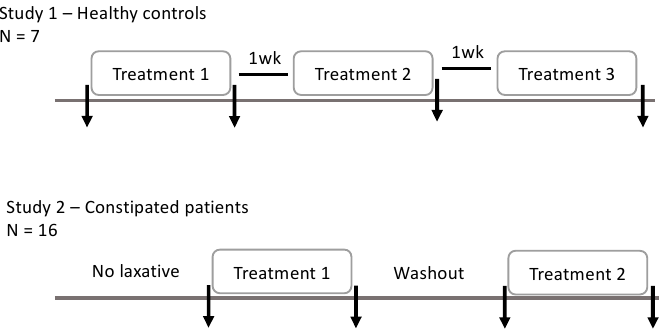
Figure 6. Study outline. The arrows indicate faecal sample collection